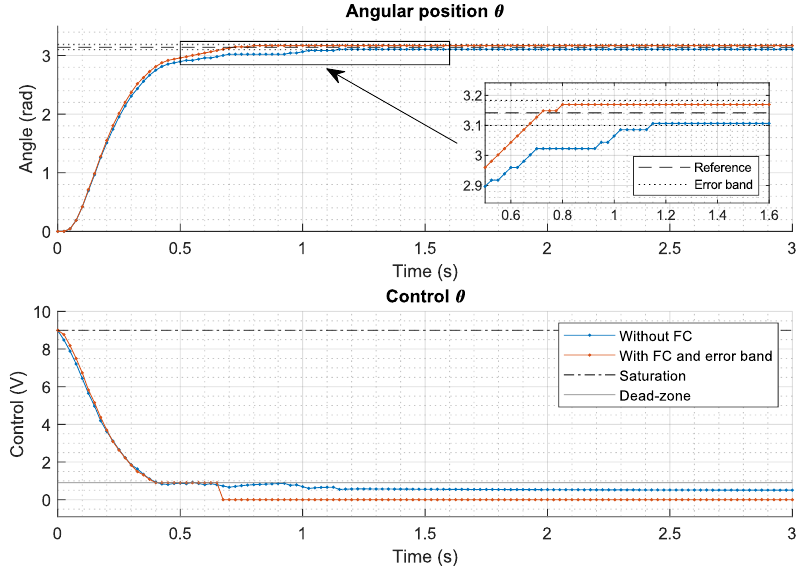
Figure 13. System response with friction compensator and error band